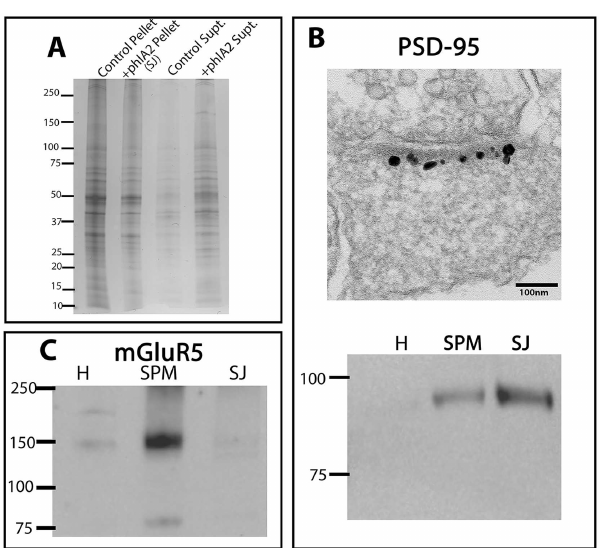
Fig 3. Verification of synaptic junction fraction. A) Synaptic plasma membrane(SPM) fractions were incubatedin presence(+phlA2) or absence(control) of phosopholipase A 2 and centrifuged (See Methods). Comparison of Coomassie Blue stained lanes shows dissociationof proteinsas a result of phospholipase A 2 digestion. B) Top: Immuno-electron microscopy shows immunogold labelingfor PSD-95 localizedselectively to the synaptic junction regionin culturedrat hippocampal neurons. Bottom: Immunoblotswith an antibody for PSD-95 show enrichmentof PSD-95 in +phlA2pellet called ‘synaptic junction’(SJ) fraction comparedto parent homogenate (H) and SPM fractions. Equal amounts of protein were loadedinto each lane. The relative enrichment of PSD-95 in the SJ fraction, as comparedto that in the parent SPM fraction, was estimated as the ratio of peak areas from densitometric scans. The mean enrichment factor (fold enrichment) from seven immunoblots correspondingto four different SJ preparations was 3.2 ± 0.76. C) Immunoblotwith an antibody for mGluR5 shows enrichment of mGluR5 in the SPM fraction comparedto the parent homogenate fraction, whilethere are decreasedlevels of mGluR5 in the SJ fraction comparedto parent SPM fraction. Equal amounts of protein were loadedinto each